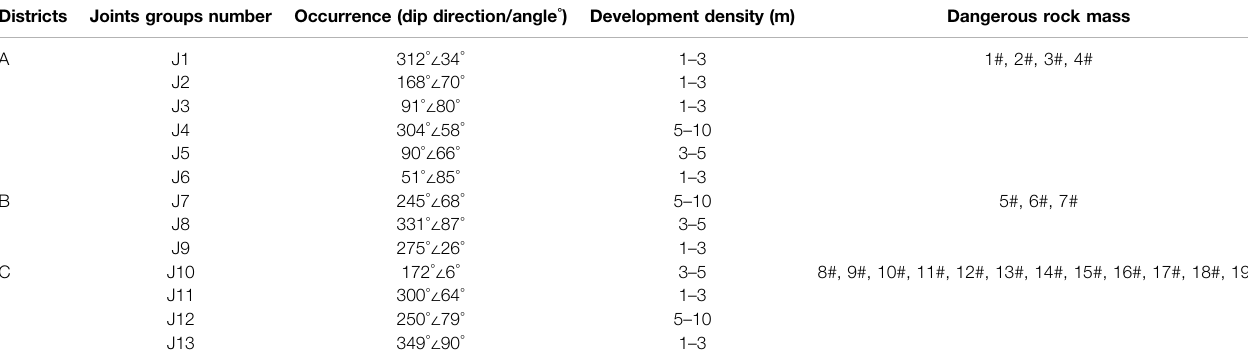
TABLE 1 | Statistics pertaining to joint groups and dangerous rock masses in different districts. Districts Joints groups number Occurrence (dip direction/angle ° ) Development density